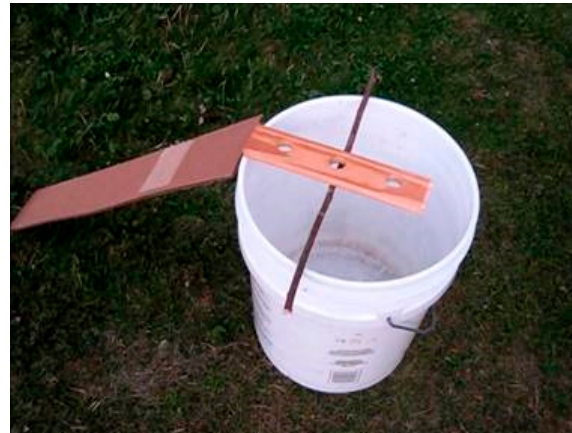
Adm. Sci. 2017 , 7 , 23